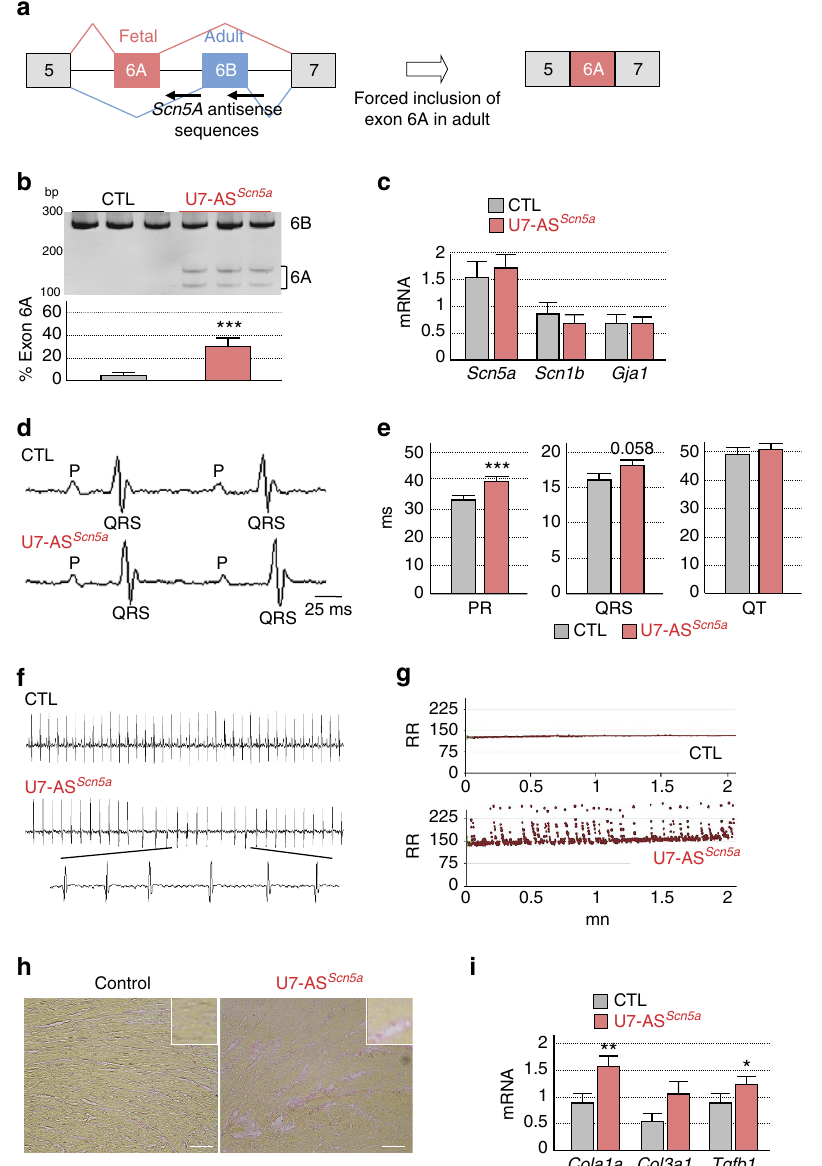
Figure 6 | Alteration of Scn5a splicing causes heart conduction defects and arrhythmias. ( a ) Schematic representation of mutually exclusive exons 6A and 6B of Scn5a and of antisense sequences driven by optimized U7-snRNAs (U7-AS Scn5a ) to force fetal exon 6A inclusion in adult wild-type mouse heart. ( b , upper) RT–PCR analysis of the alternative splicing of endogenous Scn5a mRNA from heart samples of mice injected with AAV2/9 expressing U7-AS Scn5a compared with control injected mice. Molecular size marker is indicated in bp. (lower) Percentage of Scn5a mRNA including exon 6A. ( c ) Real- time RT-qPCR quantification of the expression of Scn5a, Scn1b and GJja1 (connexin 43) mRNAs in heart samples of mice expressing U7-AS Scn5a ( n ¼ 6) compared with control injected mice ( n ¼ 6). ( d ) Representative ECG traces show prolongation of the PR interval in U7-AS Scn5a -injected mice compared with control mice. ( e ) ECG measures of PR interval, QRS and QT intervals in 4-month-old mice injected with AAV2/9 expressing U7-AS Scn5a ( n ¼ 25) compared with age-matched control mice ( n ¼ 17). ( f ) Representative ECG traces reveal atrial fibrillation in U7-AS Scn5a -injected mice compared with control mice. ( g ) Variation of the RR interval indicates evidences of heart arrhythmias in U7-AS Scn5a -injected mice ( n ¼ 25) compared with control mice ( n ¼ 17). ( h ) Representative image of six analysed heart samples showing mild fibrosis revealed by Red Sirius histology staining in AAV-U7-AS Scn5a -injected mice. Scale bar, 100 m m. ( i ) Real-time RT-qPCR quantification of the expression of Cola1a, Col3a1 and Tgfb mRNAs in heart of control ( n ¼ 6) or AAV-U7- AS Scn5a -injected mice ( n ¼ 6). Bars indicate s.e.m. Student test, * indicates P o 0.5, ** indicates P o 0.01, *** indicates P o 0.001. bp, base